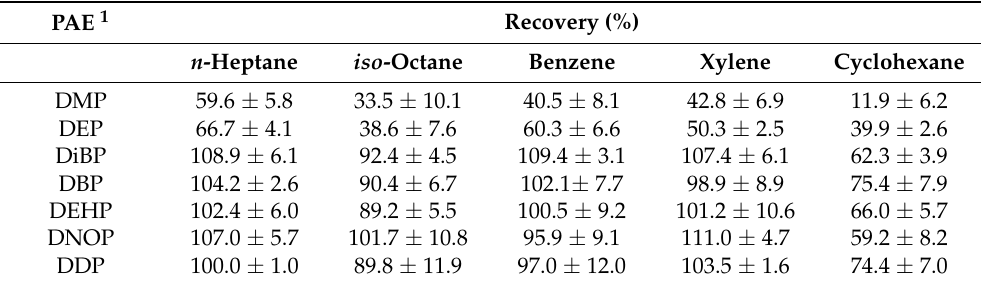
Table 2. PAE recoveries (%) related to different extraction solvents tested in this study. PAE 1